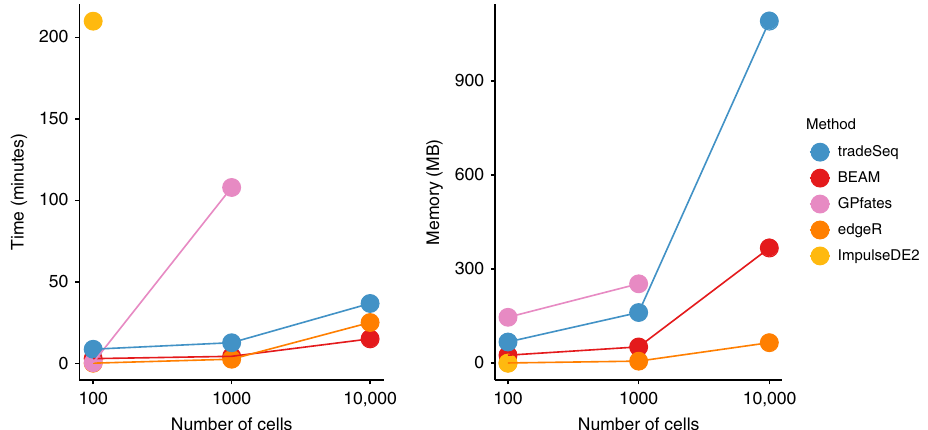
Fig. 4 Benchmark of computation time and memory usage. Data sets with 100, 1000, and 10,000 cells are simulated and each method is evaluated, respectively, 10, 2, and 2 times on each data set to assess computation time and memory usage. The average across iterations is plotted for each method. Methods that went over a 4-h mark were stopped and deemed taking too